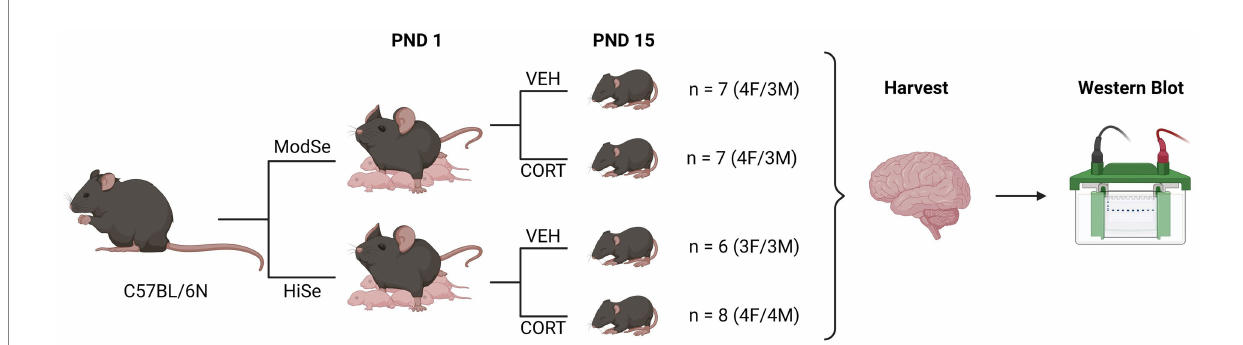
FIGURE 1 Summary of experimental design. Wild-type C57BL/6 N mice were mated while being fed chow that contained either a moderate selenium (ModSe, 0.25 ppm) or high selenium (HiSe, 1 ppm) content. Following the birth of a litter, on postnatal day 1 (PND1), either corticosterone (CORT, 75 μ g/ml), or vehicle control (1% grain alcohol) were added to the drinking water, and replaced twice weekly. On PND15, the entire litter was sacrificed and brain regions were harvested for western blot